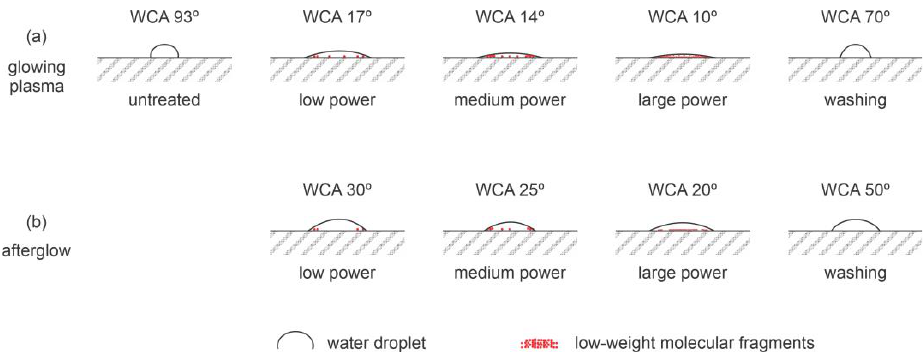
Figure 1. Schematic surface effects during PEEK treatment with weakly ionized oxygen plasma ( a ) and oxygen plasma afterglow ( b ).